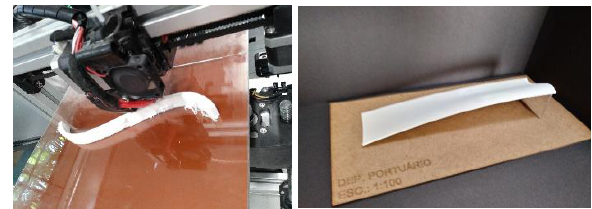
Figure 9: Rapid prototyping process and half-a-module produced using FDM on a Felix 3.1.